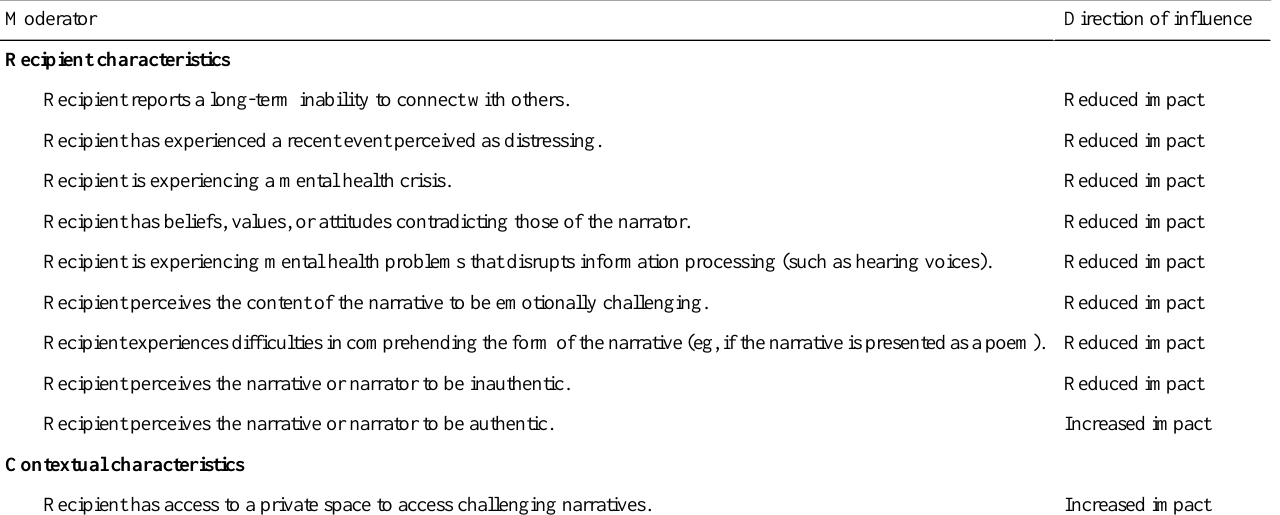
Direction of influenceModerator